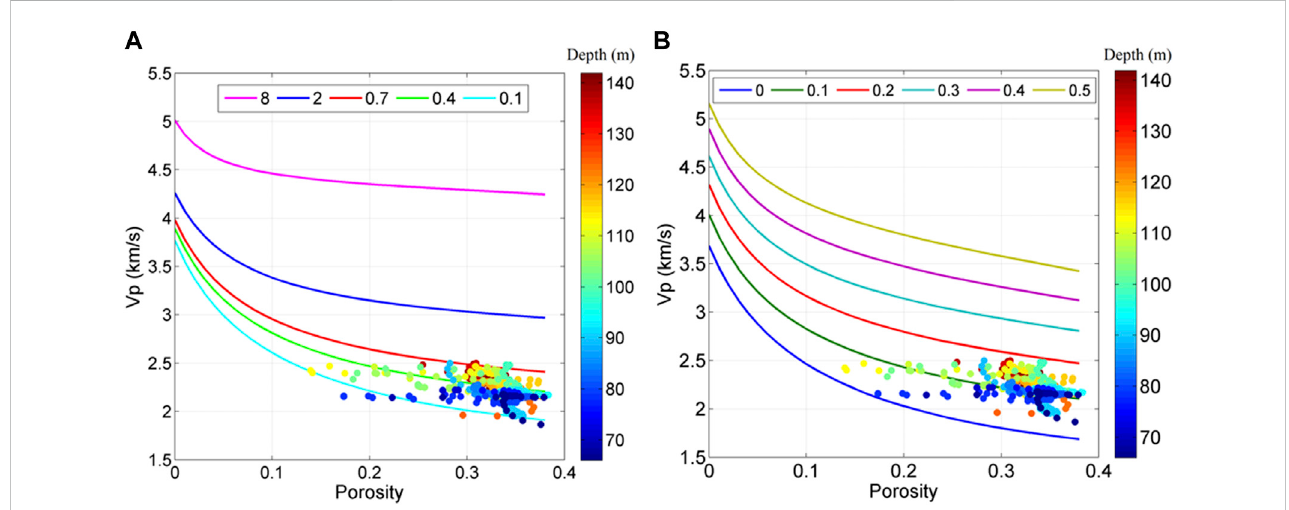
FIGURE 12 Simulated P-wave velocities with (A) the Hertz – Mindlin model and (B) iso-frame model.